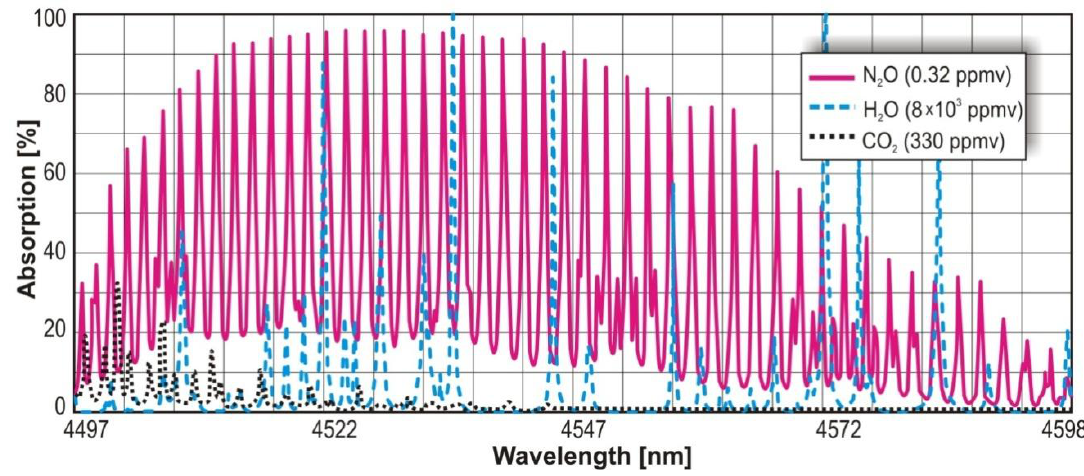
Figure 4. N O absorption 2